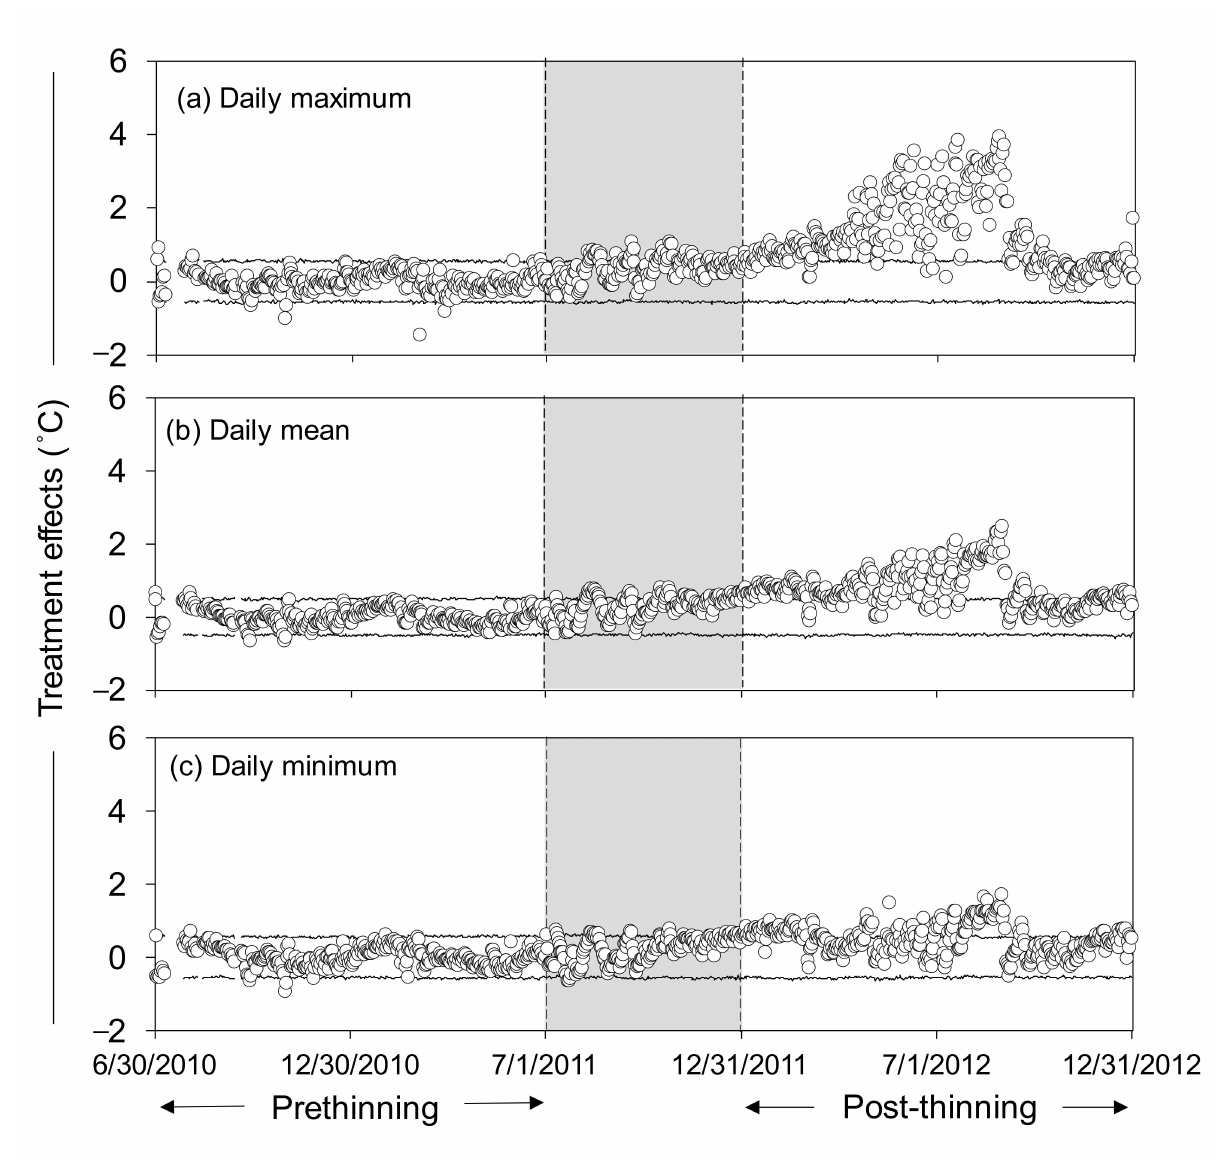
Figure 5. Time series of treatment effects for ( a ) daily maximum stream temperature, ( b ) daily mean stream temperature, and ( c ) daily minimum stream temperature at the K T catchment. The black horizontal lines indicated 95% prediction intervals for treatment effects. Shaded area indicates during thinning operation